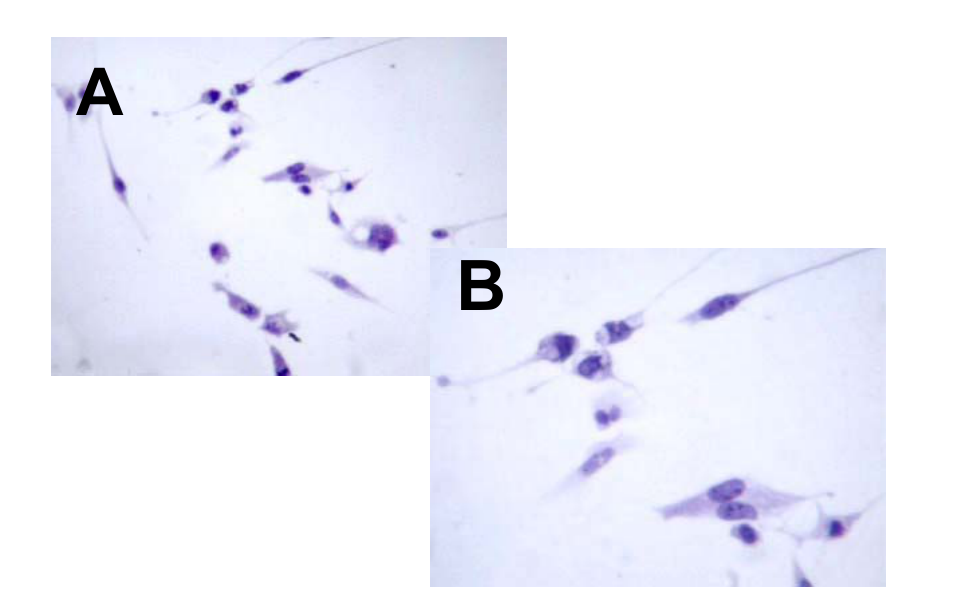
Fig. 3 Specific effects of HSV-1 on TV cells (HE staining: (A) HE × 200, (B) HE × 400).